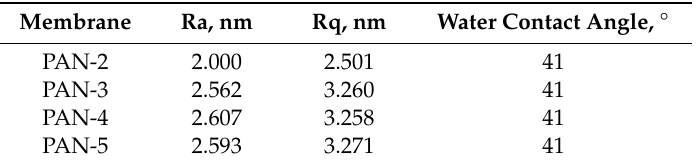
Table 1. Roughness characteristics and water contact angles for porous PAN membranes (substrates). The mean accuracy was < ± 2% for roughness characteristics and ± 2 ◦ for contact angle. Membrane